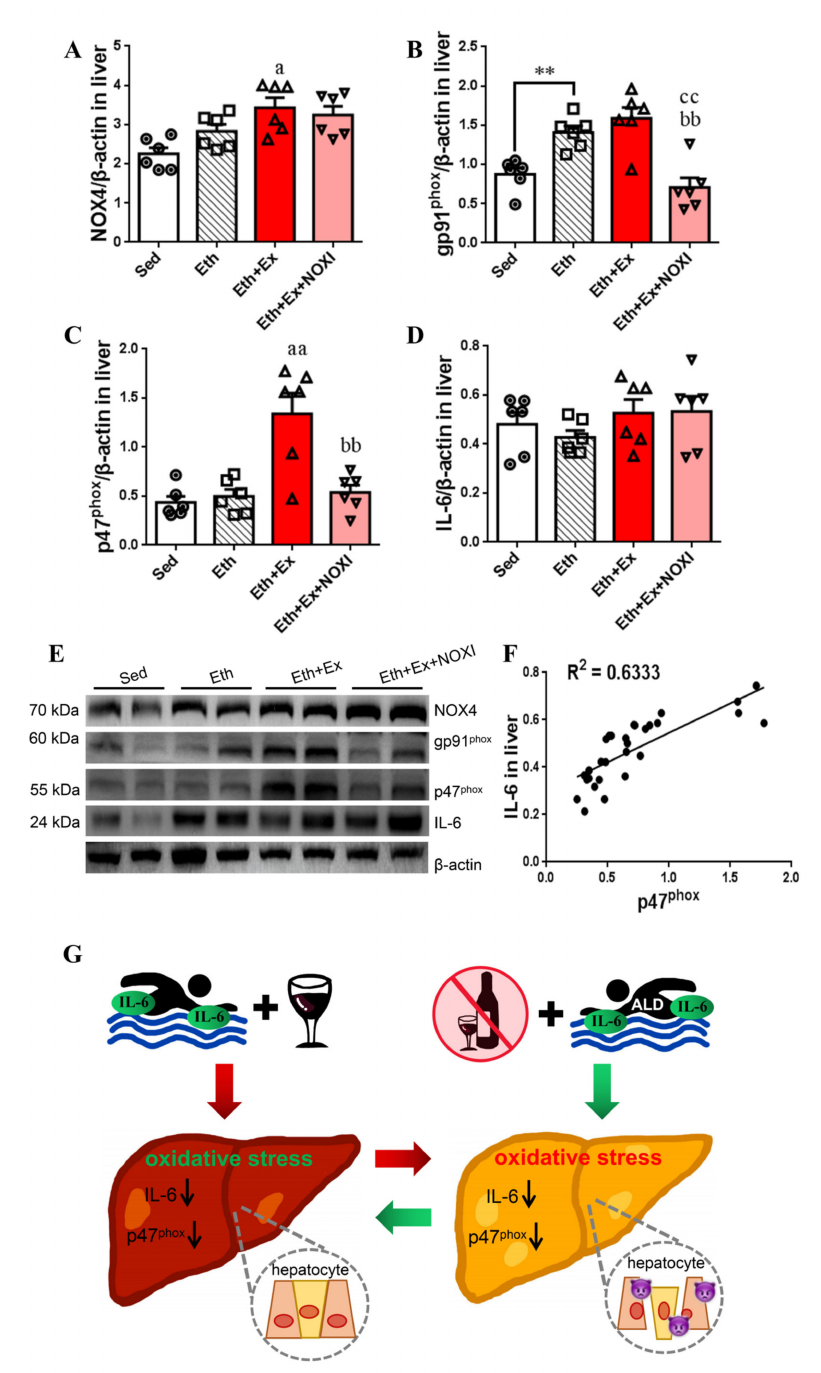
Figure 6. Verification of the correlation between IL-6 and p47 phox protein in liver tissue. ( A – E ) NOX4, gp91 phox , p47 phox , and IL-6 protein expression levels in liver tissue by WB. ( F ) Correlation between IL-6 and p47 phox protein expression in liver tissue. ( G ) Schematic diagram of effects of drinking alcohol during exercise and exercise intervention during the recovery phase of ALD on liver oxidative stress response and liver-cell inflammation damage. The molding effect is represented by *, ** p < 0.01. The exercise effect is denoted by a, a p < 0.05 and aa p < 0.01. The drug effect is denoted by b, bb p < 0.01. The effect of combined exercise and drug intervention is indicated by c, cc p <